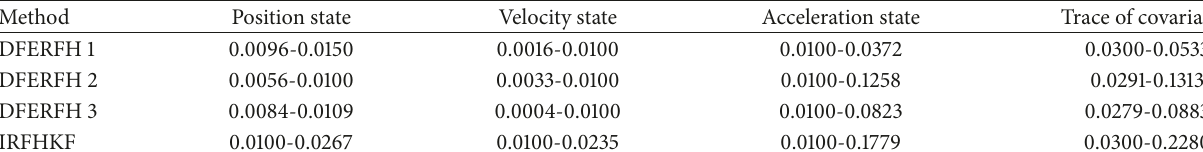
Table 1: Comparison of the filtering error covariance matrices.